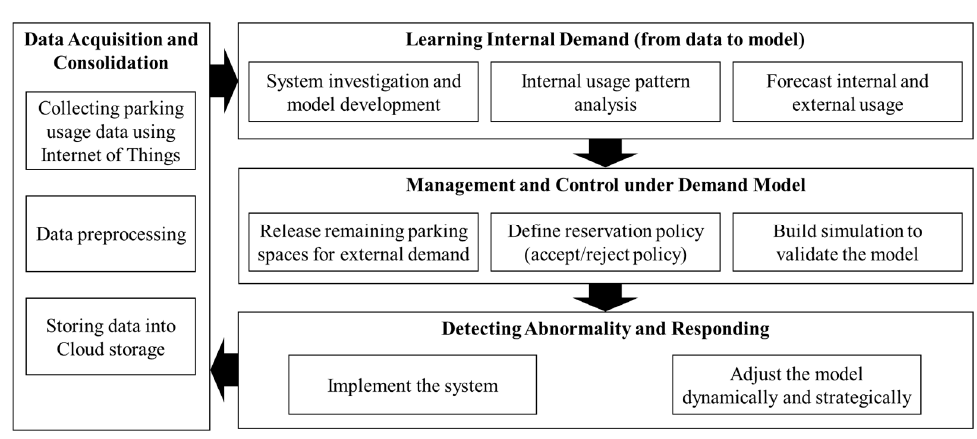
Figure 2. Framework of the proposed shared parking system.